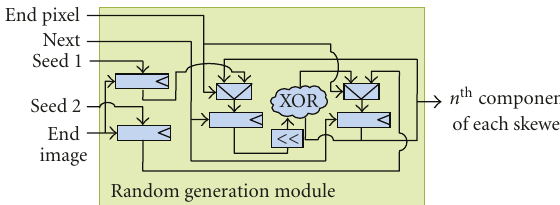
Figure 8: Hardware architecture of the random number generation module.